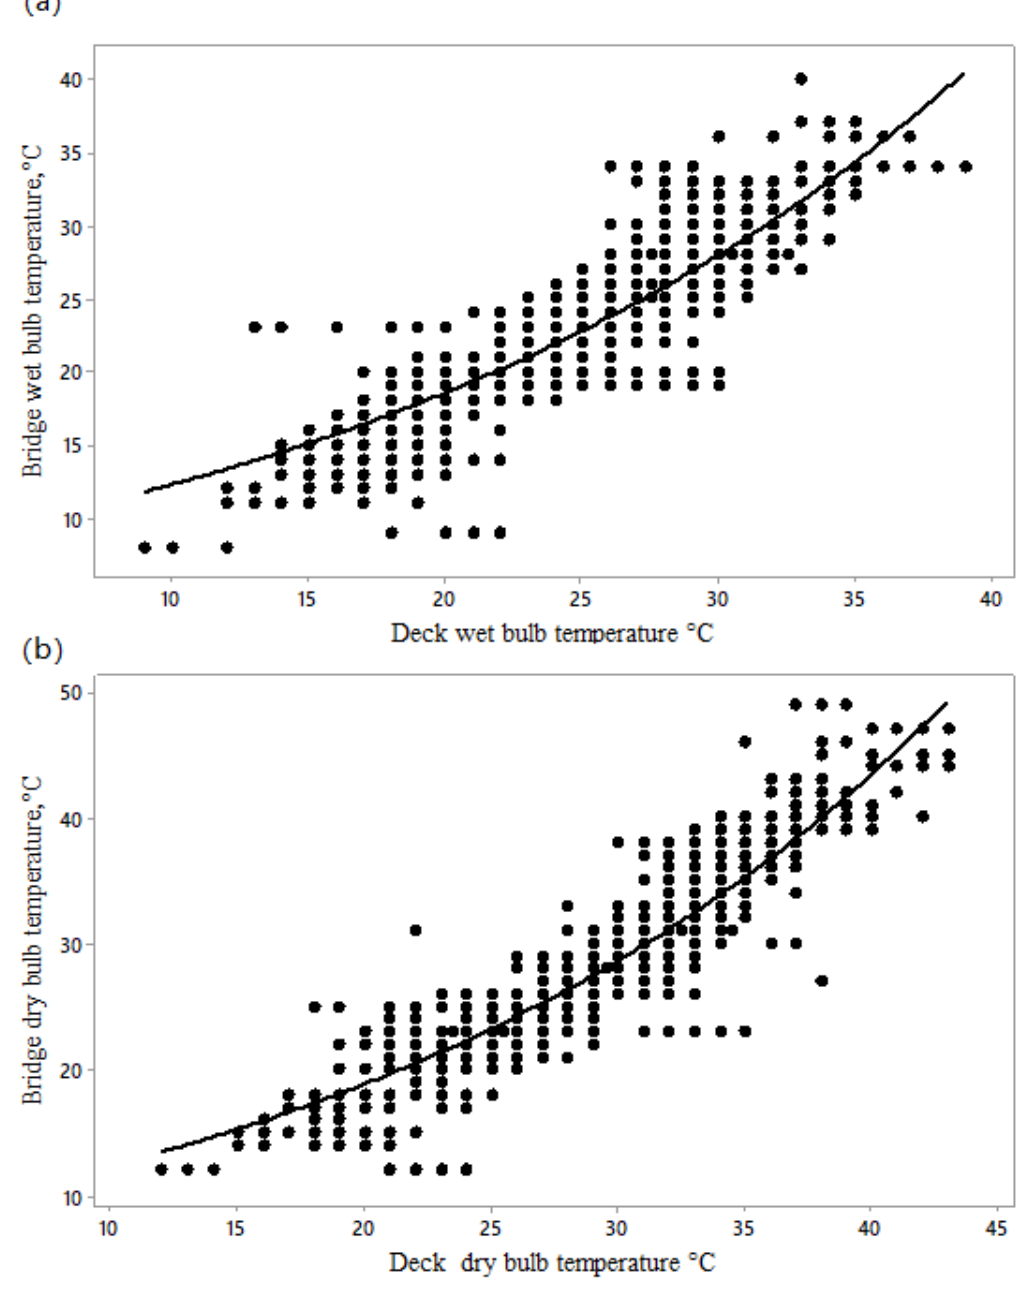
Figure 2. Non-linear exponential models for the relationship between T WB ( a ) and T DB ( b ) on sheep decks and on the bridge, described by the following equations: Bridge T WB = 8.18 (±0.11) exp (0.041(±0.0005) × Deck T WB ), F = 9.09 and p < 0.0001 (Equation 3); Bridge T DB = 8.21 (±0.105) exp (0.042(±0.0004) × Deck T DB ), F = 5.59 and p < 0.0001 (Equation 4), where all temperatures are in °C ( n = 2681).